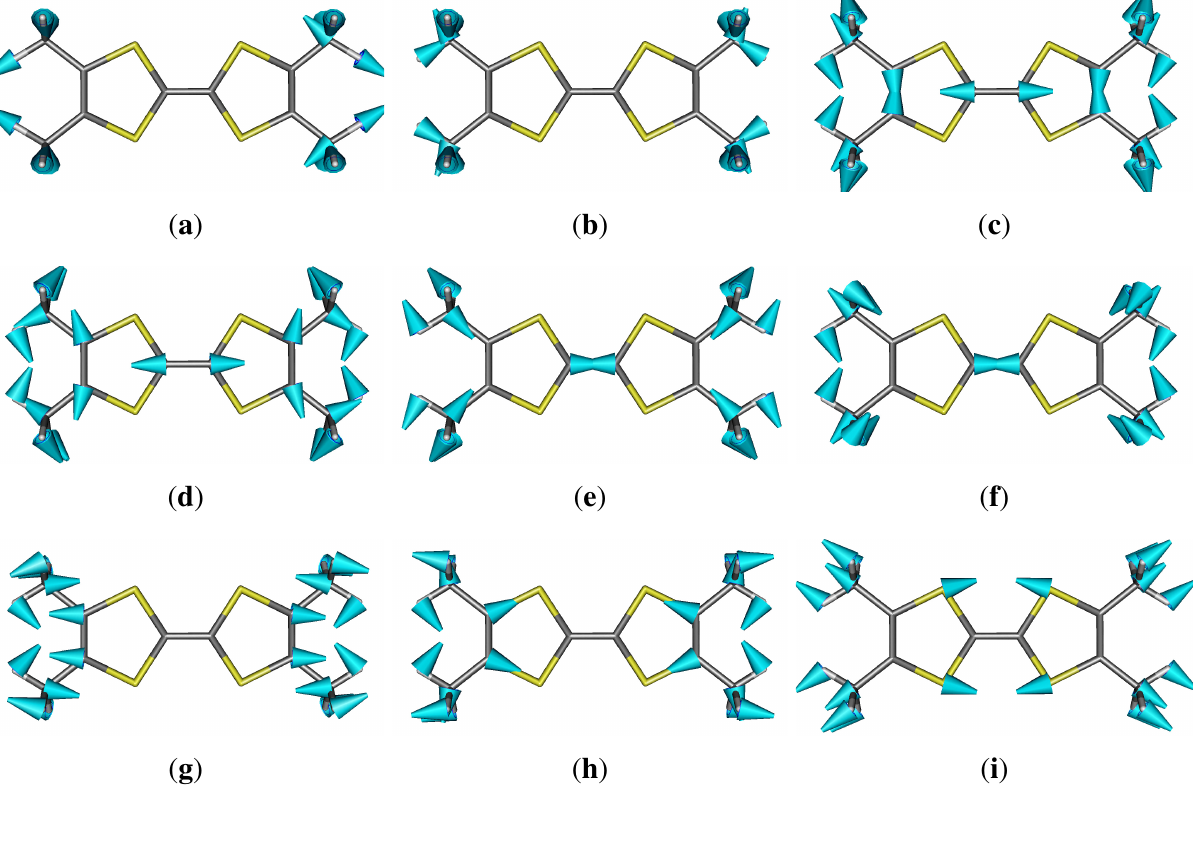
) intramolecular modes g